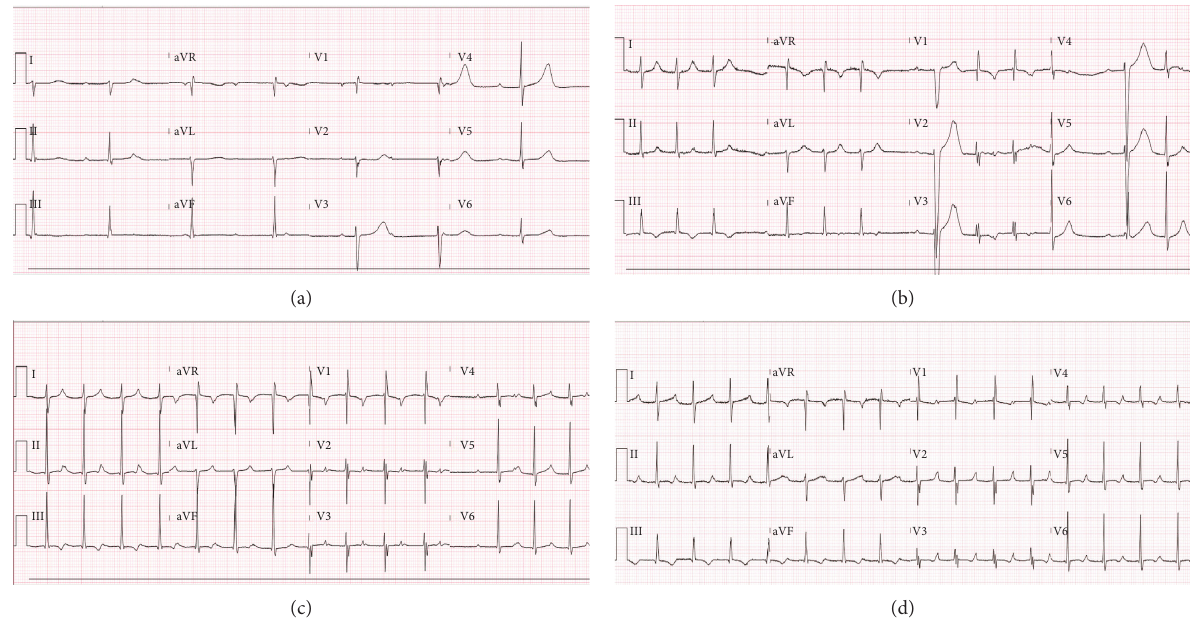
Figure 1: (a) Complete heart block with low ventricular rate of 41: hospital day #4—subsequently started isoproterenol. (b) Second-degree type 2 AV block: hospital day #5—on isoproterenol. (c) Second-degree Mobitz type 1 AV block: hospital day #7—on isoproterenol. (d) First- degree AV block: hospital day #8—on isoproterenol.